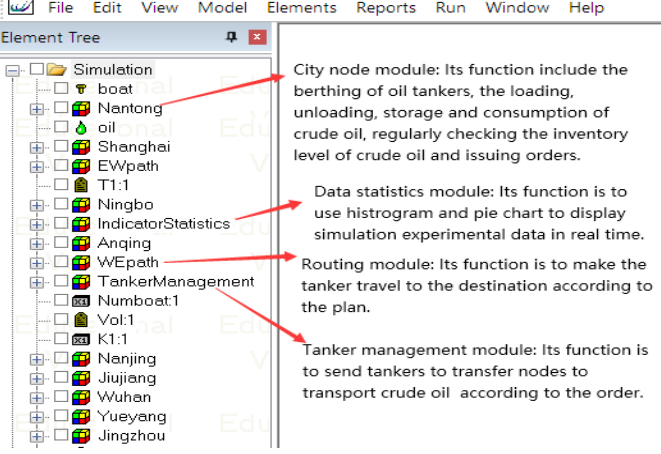
Figure 6. Module library in the system simulation model.